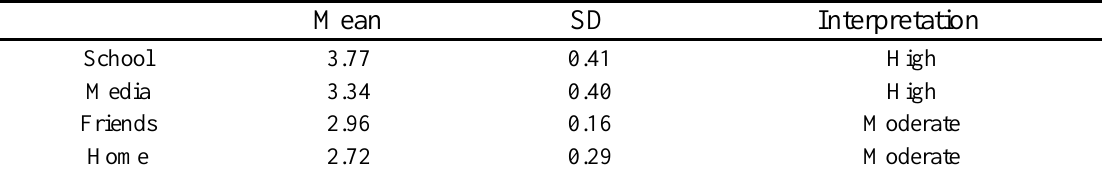
Table 3. Summary of the Distribution of Students’ Response in Each Item